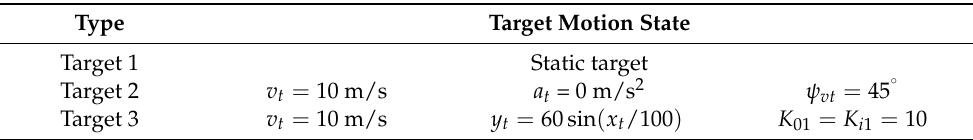
Table 2. Initial parameters of the virtual leader missile and follower missiles.